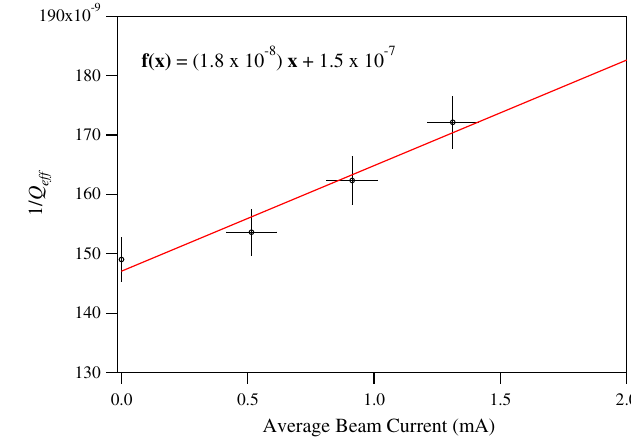
FIG. 5. (Color) A plot of 1 =Q versus average beam current eff FIG. 7. (Color) A plot of 1 =Q versus average beam current from the data in Fig. 4. The intersection of the least squares fit eff from the data in Fig. 6. The least squares fit is used to determine (functional form given on the plot) with the horizontal axis that the mode is determines the threshold current to be 2.4 mA.